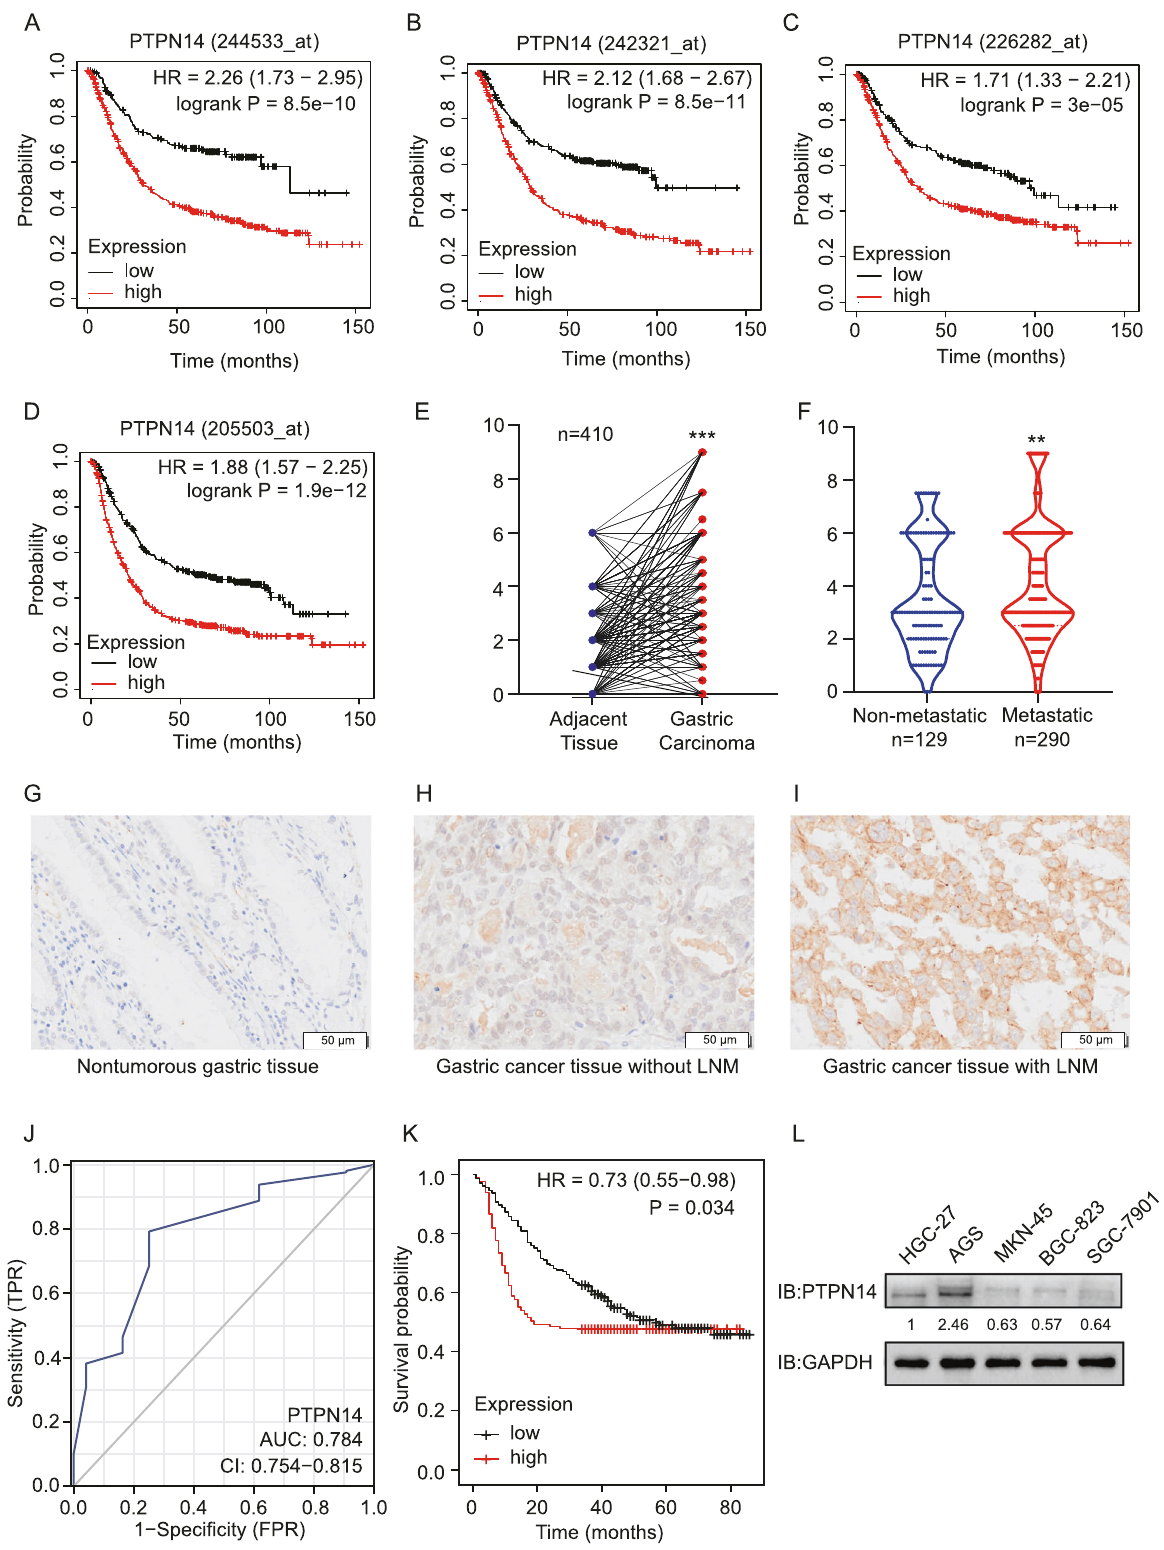
expression was irrespective of age, gender, T stage, M stage, Lauren type, mismatch repair (MMR) state, E-cadherin expression, and p53 status. However, PTPN14 expression was positively correlated with the N stage and cTNM stage. In addition, we collected fi ve gastric cancer cell lines and detected